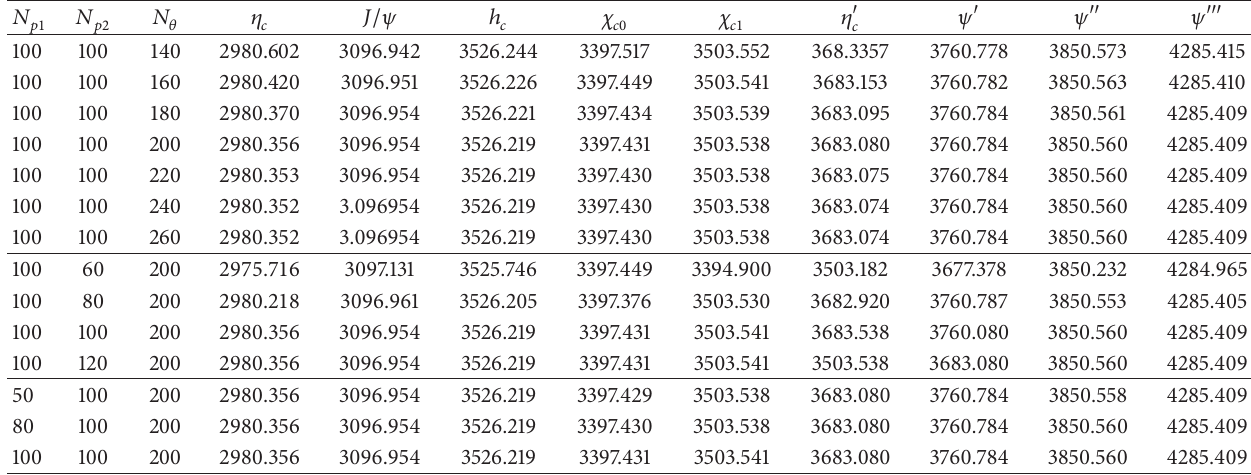
Table 4: The calculated charmonium mass spectrum as function of the number of grid points 𝑁 𝑃1 , 𝑁 𝑃1 , and 𝑁 𝜃